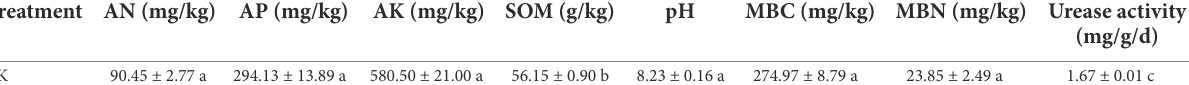
TABLE 1 Effects of melatonin and dopamine on available nitrogen (AN), available phosphorus (AP), available potassium (AK), soil organic matter (SOM), pH, soil microbial biomass C (MBC) and N (MBN), and urease activity under long-term drought